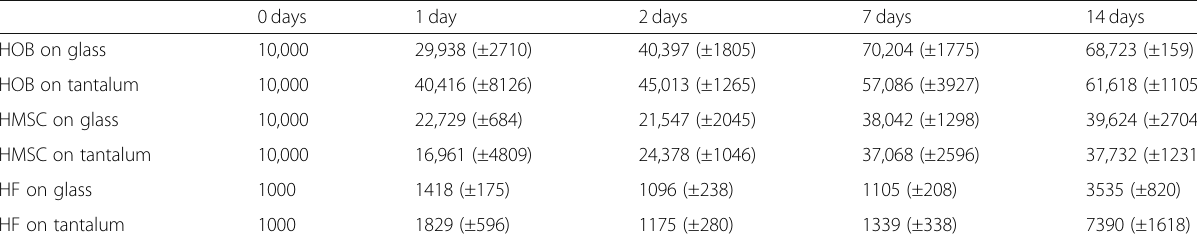
Table 1 Mean proliferated cell numbers of Human osteoblasts (HOBs), human mesenchymal stem cells (HMSCs) and human fibroblasts (HFs) cultured on glass or tantalum-coated glass substrates at 0, 1, 2, 7 and 14 days. Mean variability reported as standard deviation 0 days 1 day 2 days HOB on glass HOB on tantalum HMSC on glass HMSC on tantalum HF on glass 1000 1418 (±175) HF on tantalum